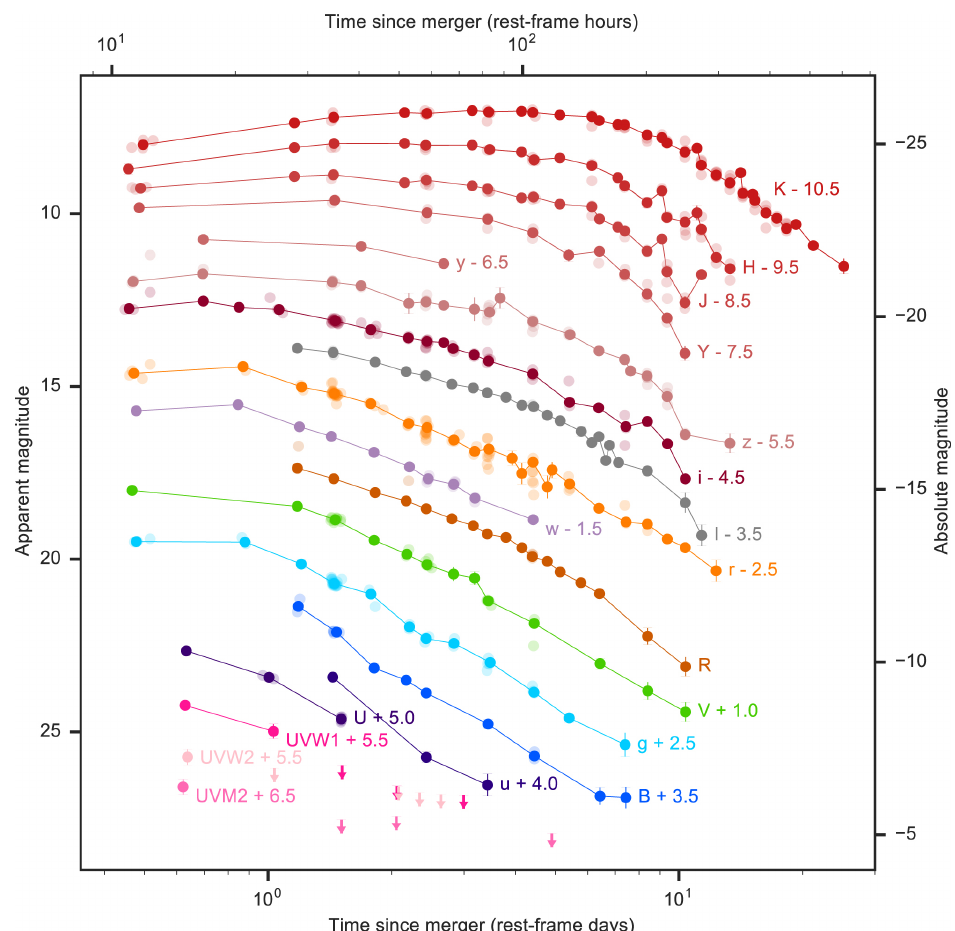
Figure 2. Light curve evolution of the kilonova associated with GW170817 / GRB 170817A (Arcavi